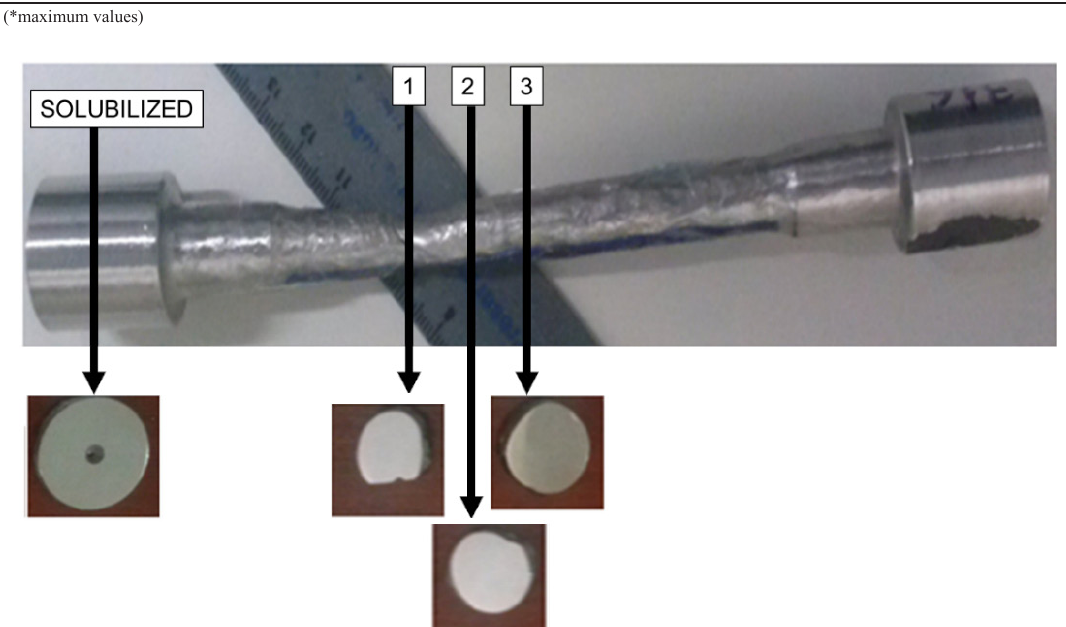
Figure 1. Cross sections of BS EN 10283 Nº 14587 stainless steel subjected to cold